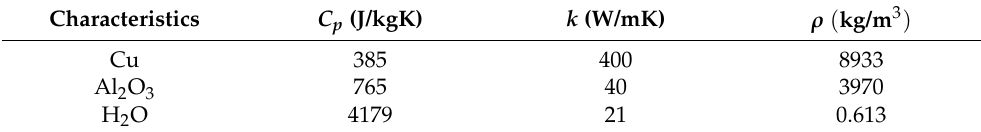
Table 2. The nanoparticles and base fluid properties. (see Oztop and Abu-Nada [60]).